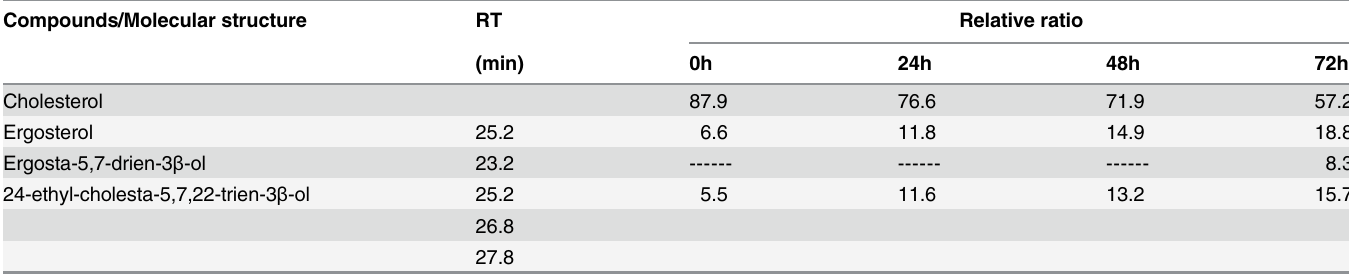
Table 4. Total sterols present in T . cruzi epimastigotes kept in LIT supplemented with 10% dFCS for 0, 24, 48 and 72h. Compounds/Molecular structure